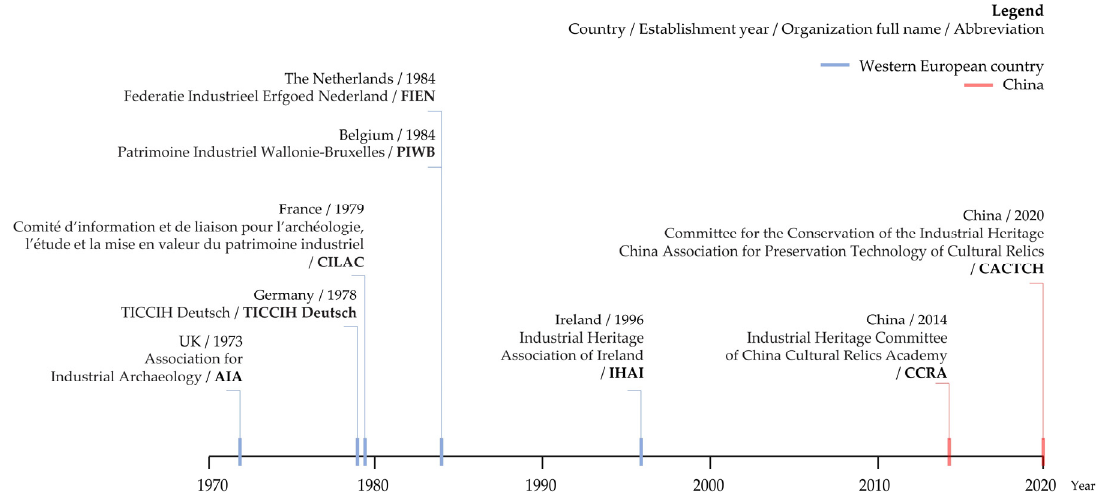
Figure 2. Establishment of major industrial heritage protection organisations in typical Western European and Chinese regions.